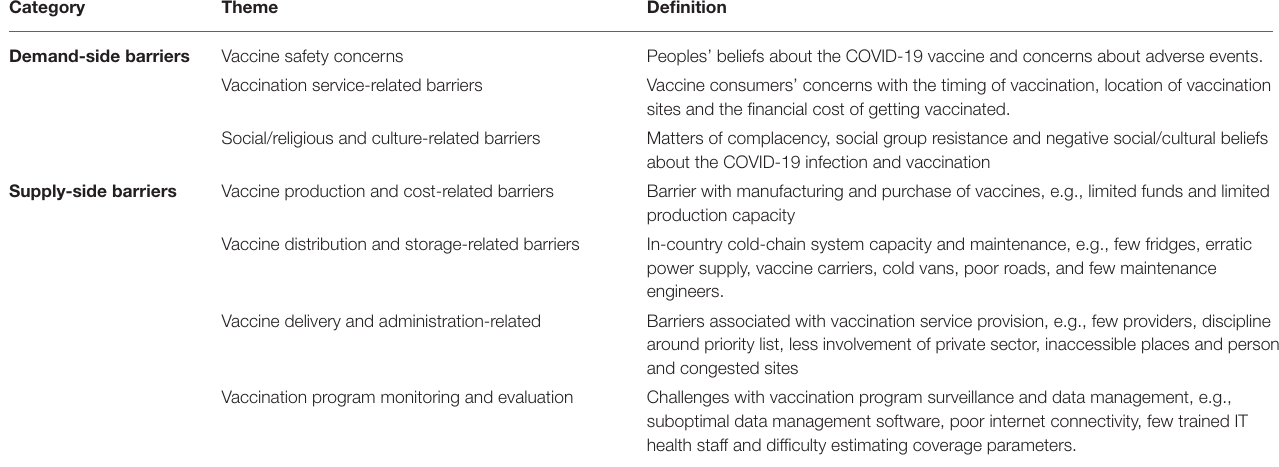
TABLE 2 | Definition of themes.